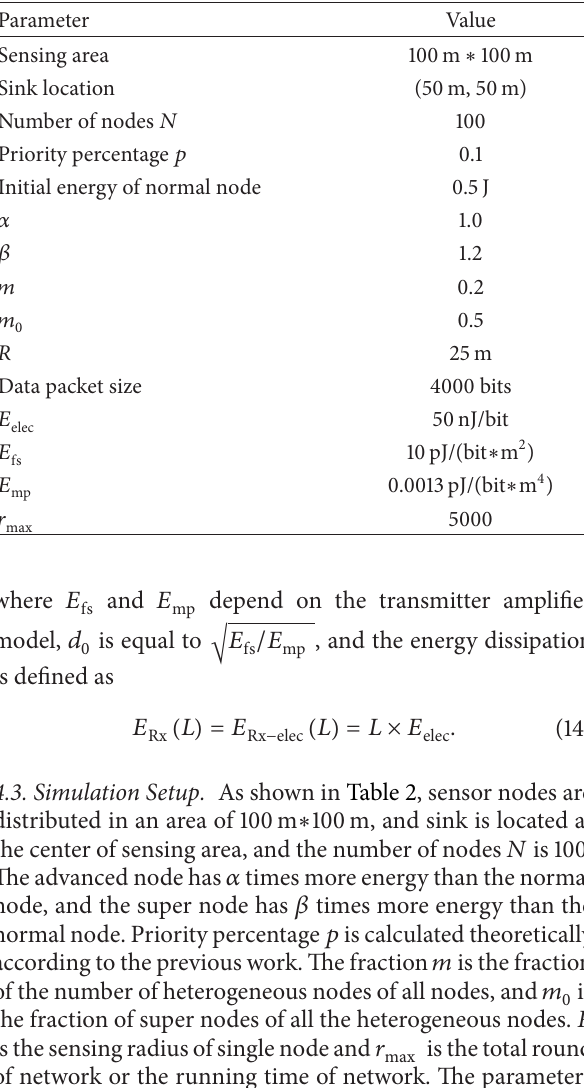
Table 2: Basic parameters used in